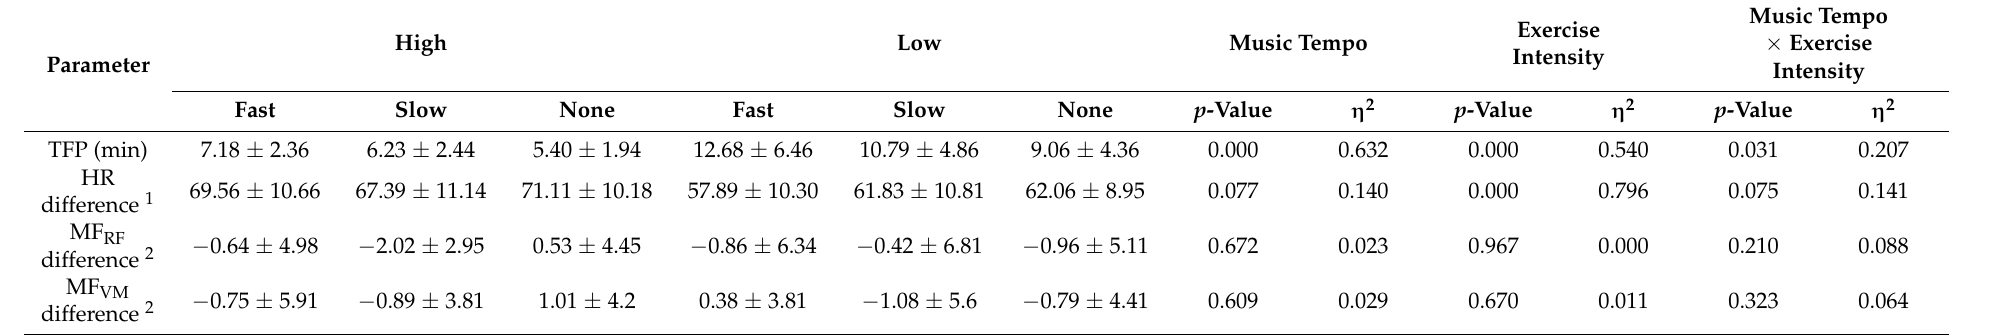
Table 4. Examination of the effects of music tempo and exercise